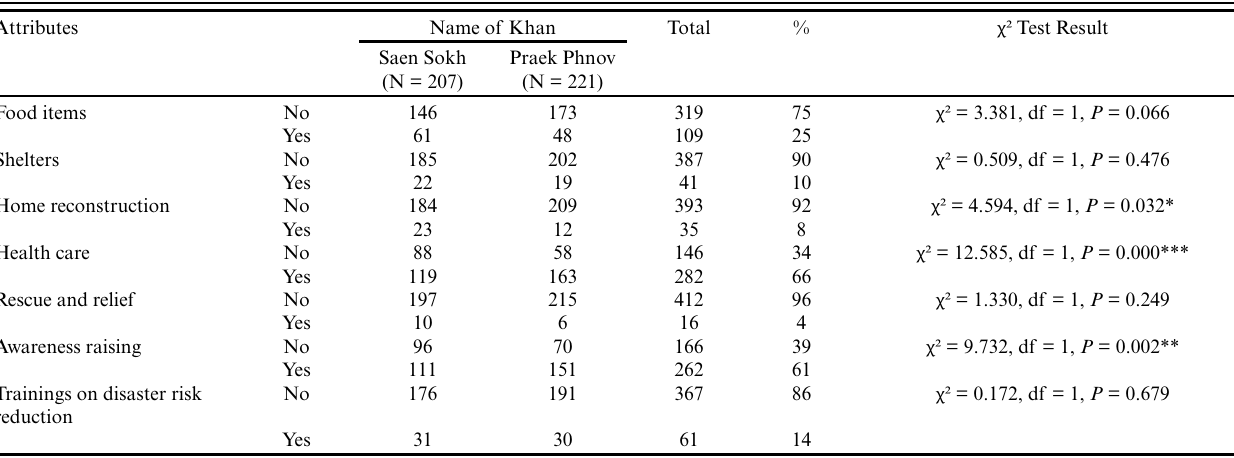
Table 5 . Perceptions on external support for affected communities.